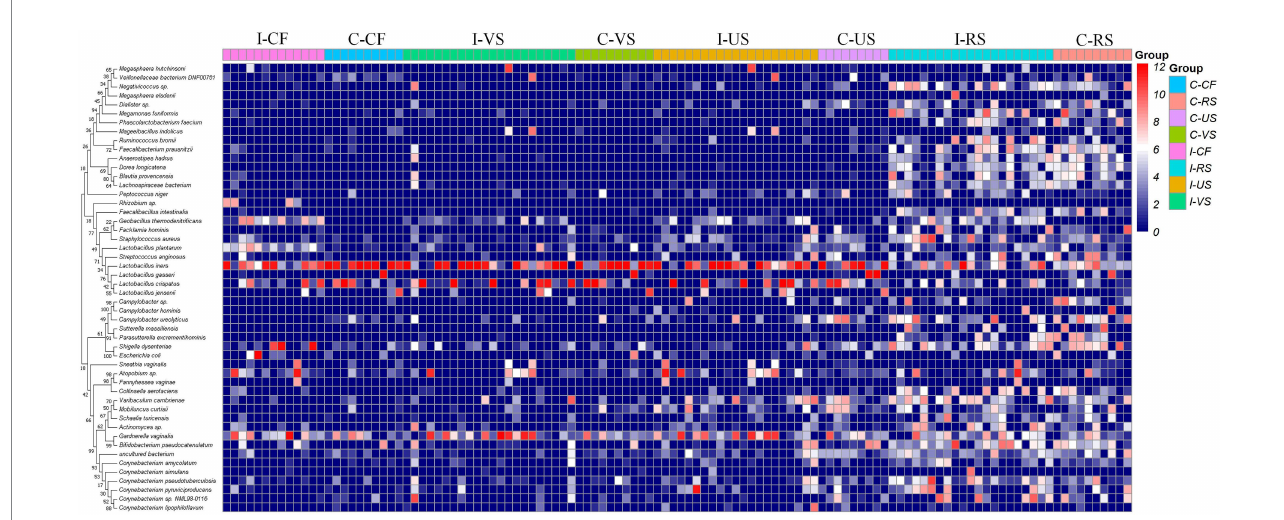
FIGURE 3 Combined diagram of heatmap and phylogenetic tree were constructed for the most abundant 50 OTUs, cervical fluid, vagina, urethra and rectal swabs of different groups were, respectively, show with different colors.